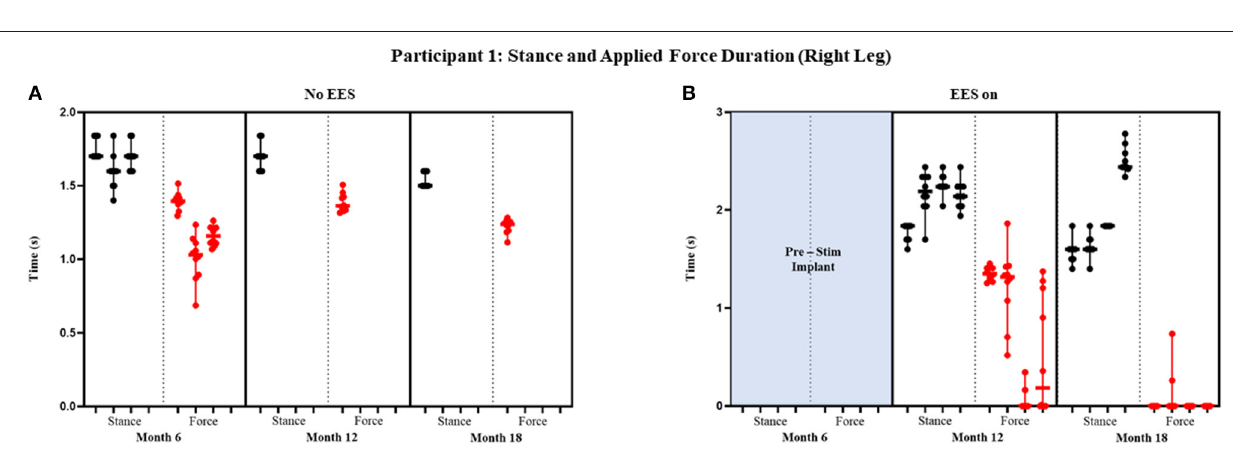
FIGURE 5 | Participant 1: stance and applied force duration right leg. Duration of stance (black dot) and applied force (red dot) with line at the median and range for right leg during no EES (A) and EES on (B) . Each tick in the x-axis represents a dataset of up to 10 consecutive cycles.